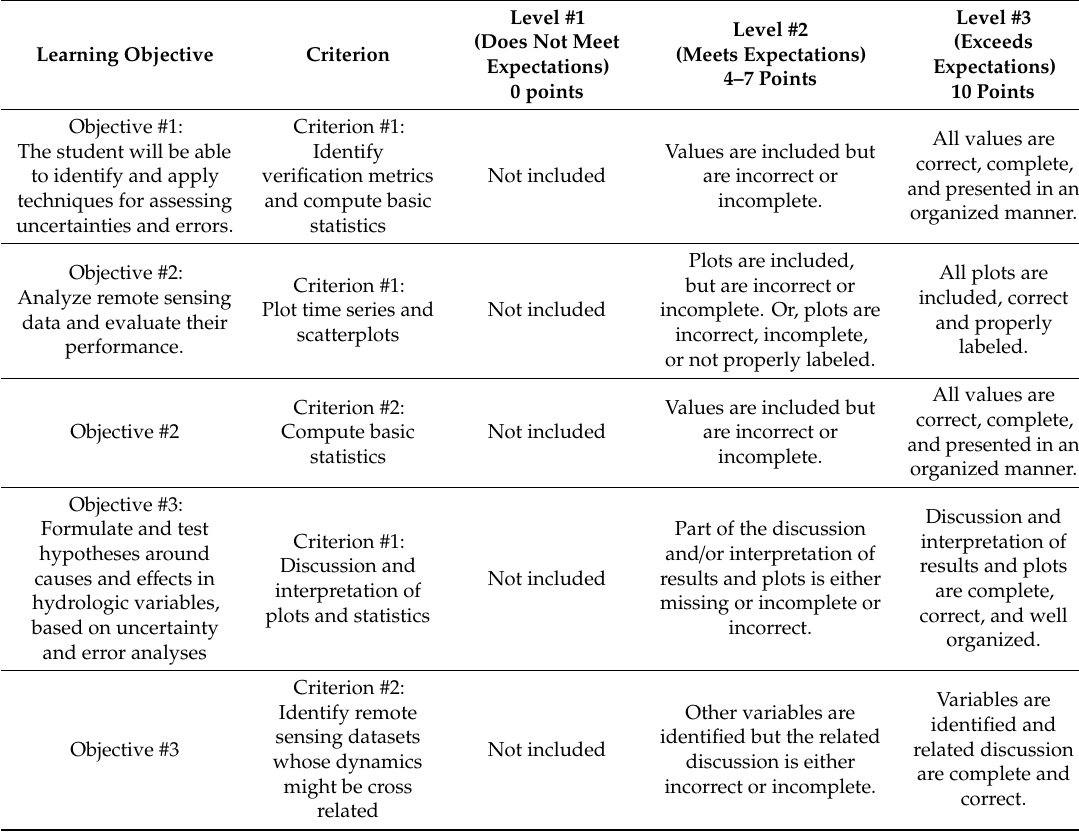
Table 4. Rubric of the learning activity in the Uncertainty and Error Assessment section (Section 4) of the Remote Sensing Applications in Hydrology